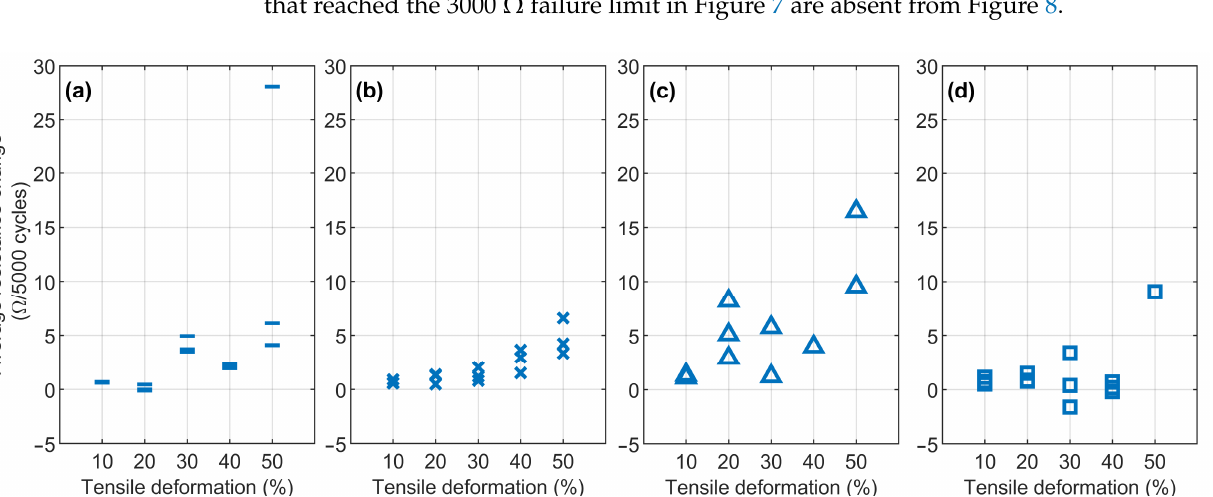
10 of 19 Figure 7. Resistance range lines of cyclic sample series, where three parallel samples are grouped